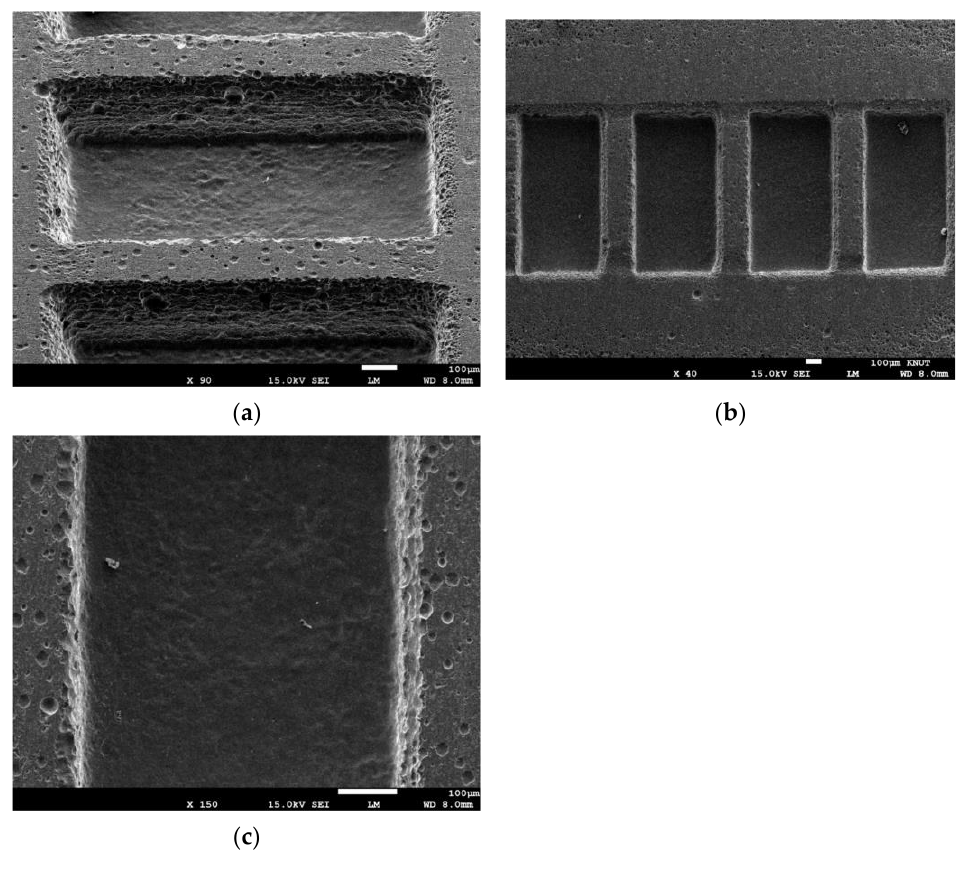
Figure 10. Microsquare groove through DEE process: ( a ) tilted view; ( b ) top view; ( c ) magnified view of microsquare groove.